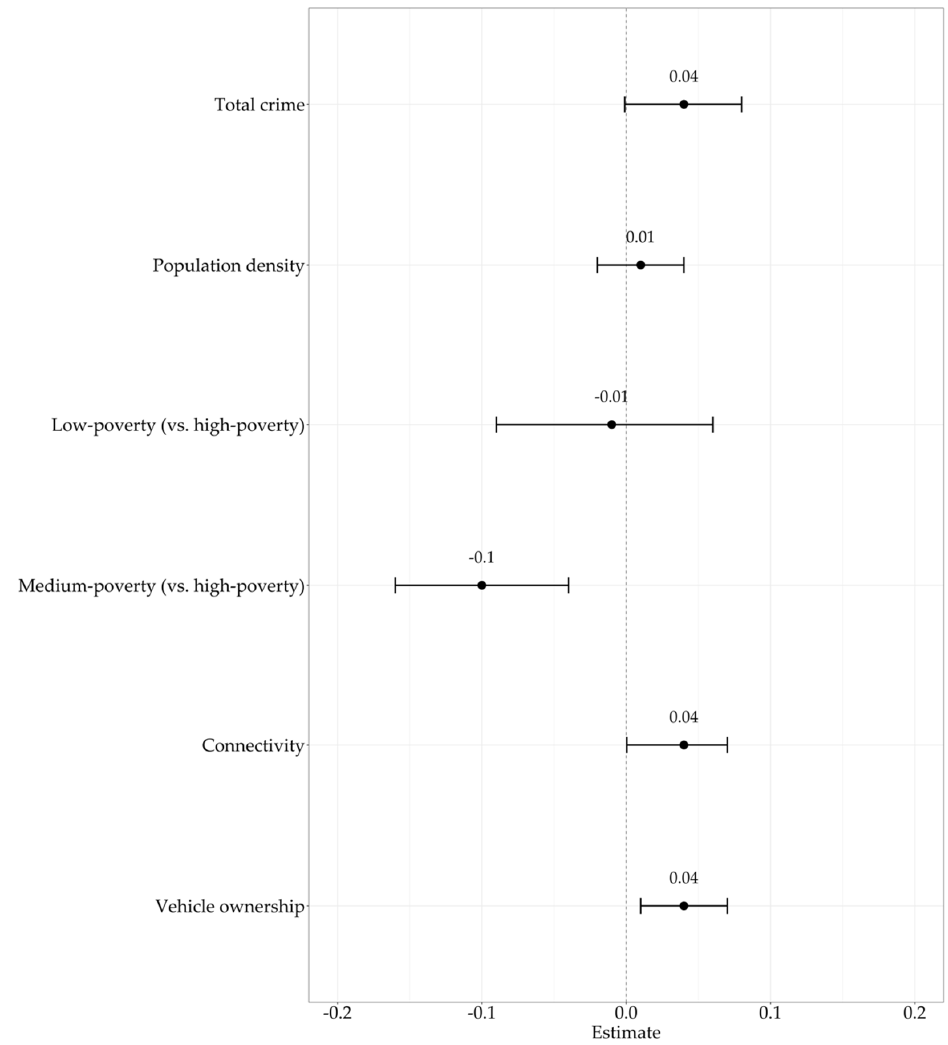
Figure 2. Mutually adjusted model for total police-reported crime and ACS .